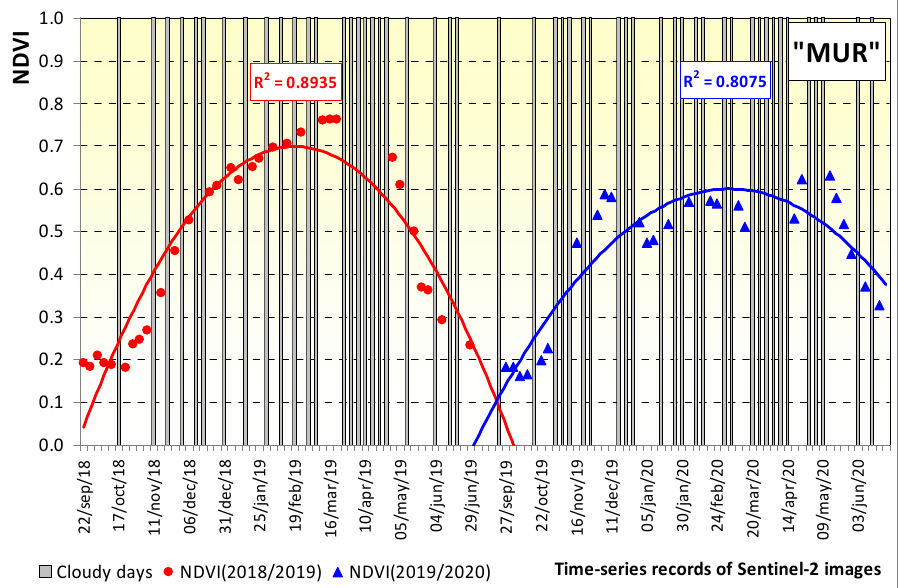
Figure 12. NDVI time-series records obtained in 2018/2019 and 2019/2020 in “MUR” field.